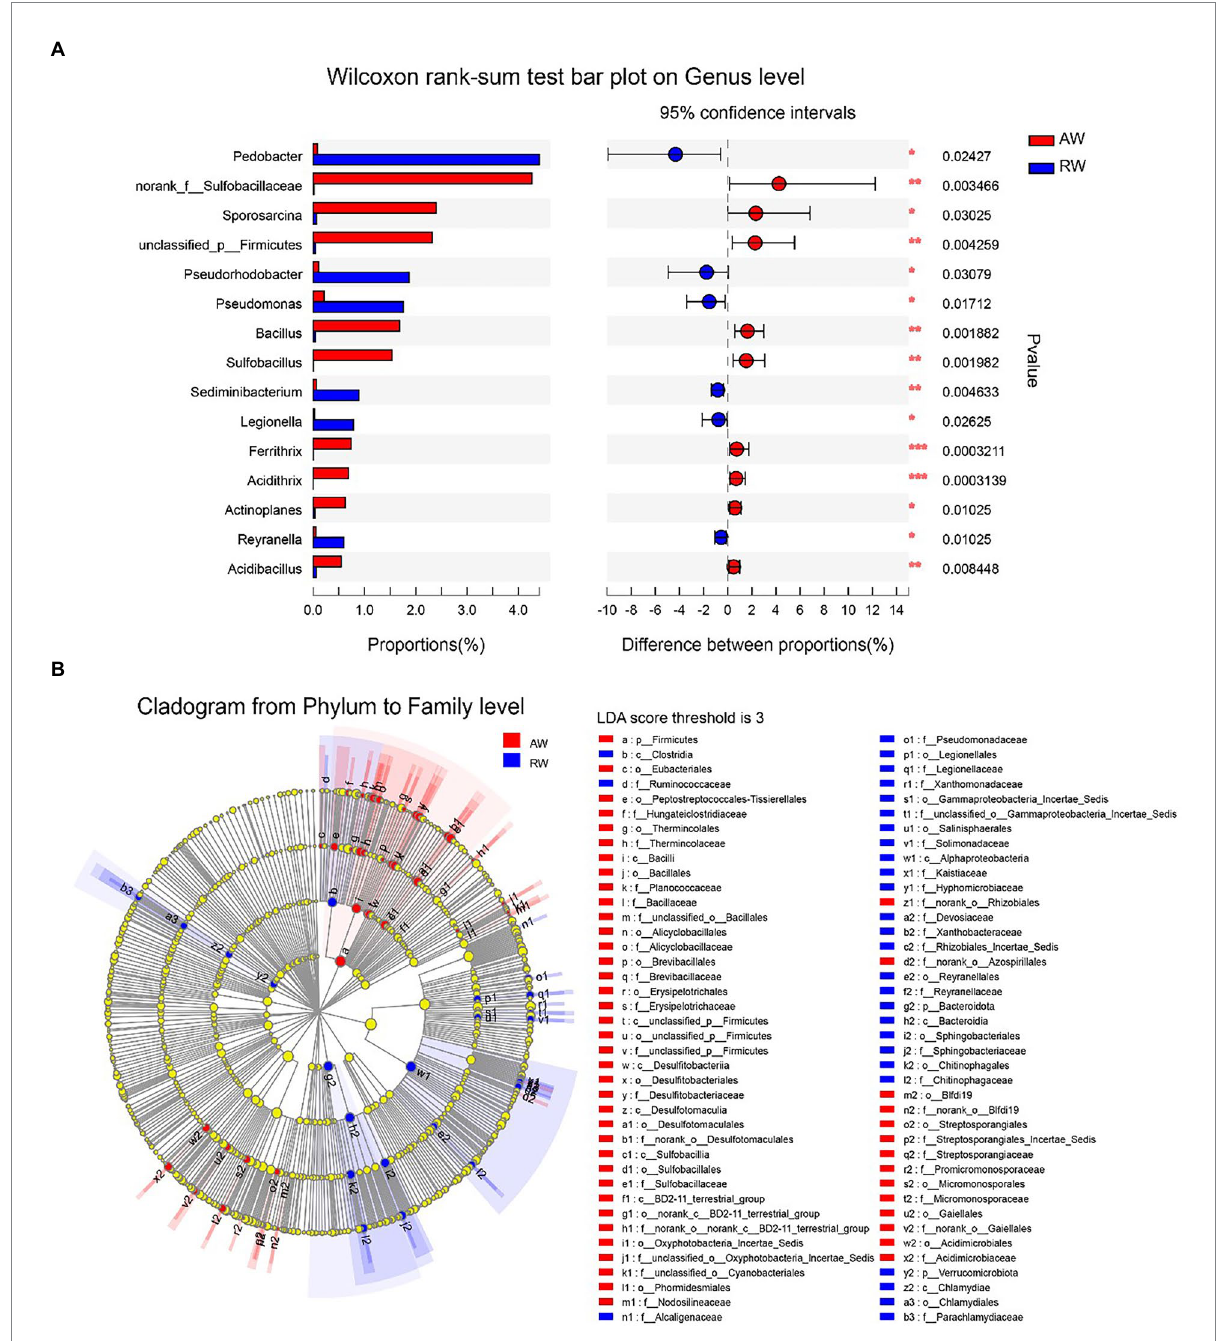
FIGURE 7 Difference analysis of microbes between RW and AW samples. (A) Wilcoxon rank-sum test bar plot on genus level. Only the differentially abundant genus is shown. The y -axis represents the taxa name, the x -axis represents the average relative abundance of taxa in different groups, and the far right is the corresponding p -value, where *0.01 ≤ p ≤ 0.05, **0.001 ≤ p ≤ 0.01, *** p ≤ 0.001. (B) LEfSe Phylogenetic dendrogram of biomarker bacteria between RW and AW samples. We first used the non-parametric factorial Kruskal–Wallis (KW) sum-rank test to detect features with significant differences in abundance, and then employed Linear Discriminant Analysis (LDA) method to estimate the magnitude of the effect of each taxa abundance on the differential